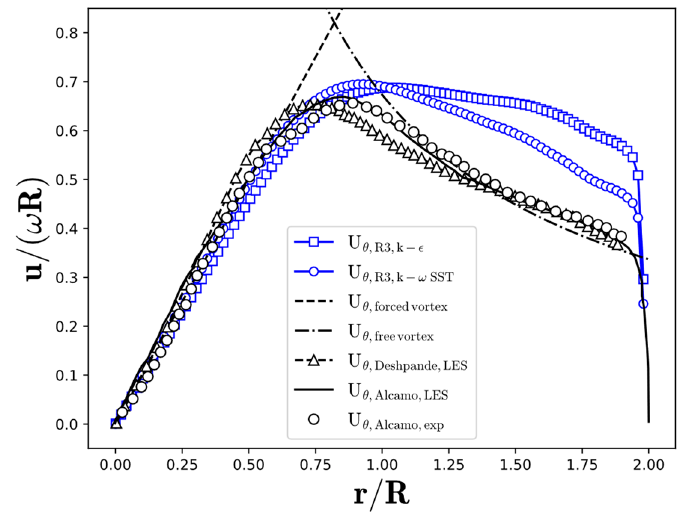
Figure 6. Normalised phase-averaged tangential velocity component along the dimensionless radial profile using the k − ε and k − ω SST model compared with LES simulation of [1,5].